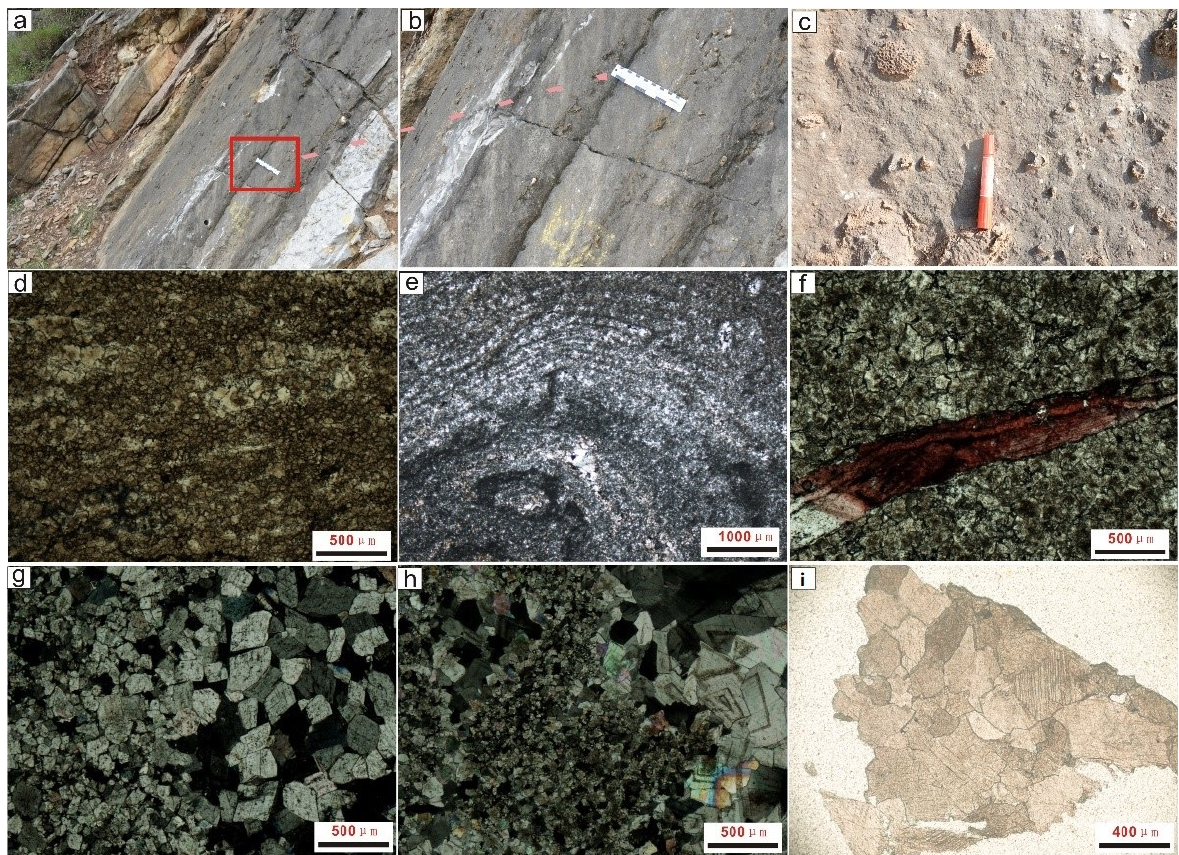
Figure 2. Photographs showing general petrographic features of GWS dolomites in the Sichuan basin: ( a ) middle-bedded reef dolomite from HJL outcrop; ( b ) an amplification of a; ( c ) organisms in the bedding surface of a; ( d ) Microcrystalline dolomite from GX outcrop; ( e ) microcrystalline dolomite from HJL outcrop with algae layer consisting of the bright and dark layers of dolomite crystals; ( f ) fine crystalline dolomite from MJB outcrop with cloudy centers surrounded by clear rims; ( g ) fine crystalline dolomite from HJL outcrop with intercrystal pore; ( h ) medium crystalline dolomite and saddle dolomite from HJL outcrop with curved crystal surface; ( i ) medium crystalline dolomite from the